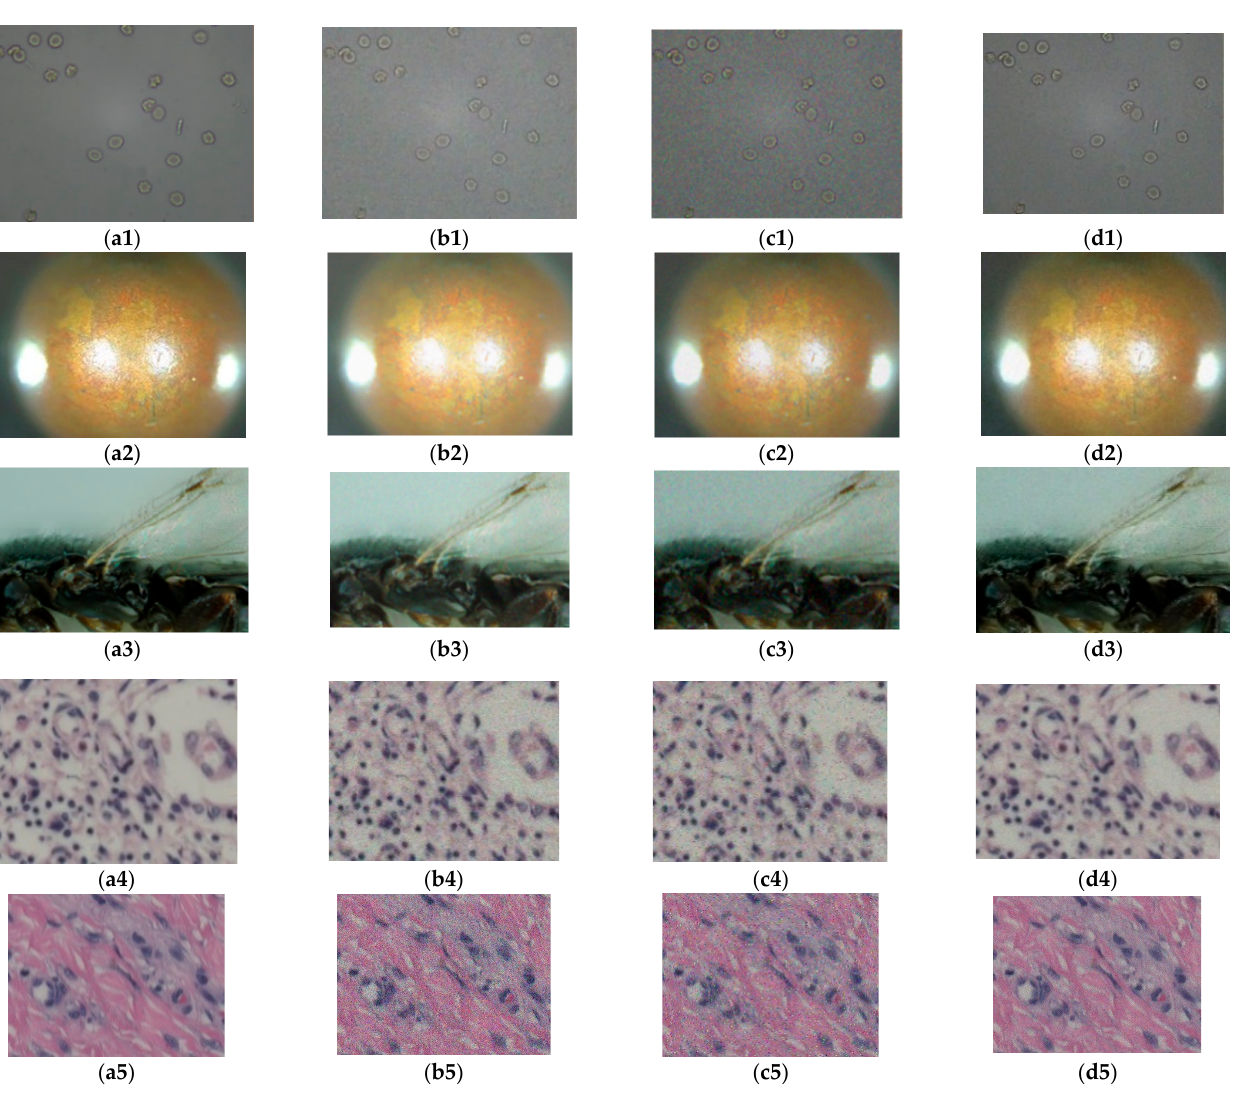
Figure 7. Image comparison: ( a1 , b1 , c1 , d1 ) are the datasets used in this study; ( a2 ) to ( d5 ) are two public datasets and two biomedical cell image sets; ( a1 , a2 , a3 , a4 , a5 ) clear cell image; ( b1 , b2 , b3 , b4 , b5 ) images with Gaussian noise added; ( c1 , c2 , c3 , c4 , c5 ) images with salt-and-pepper noise; ( d1 , d2 , d3 , d4 , d5 ) images with Poisson noise.